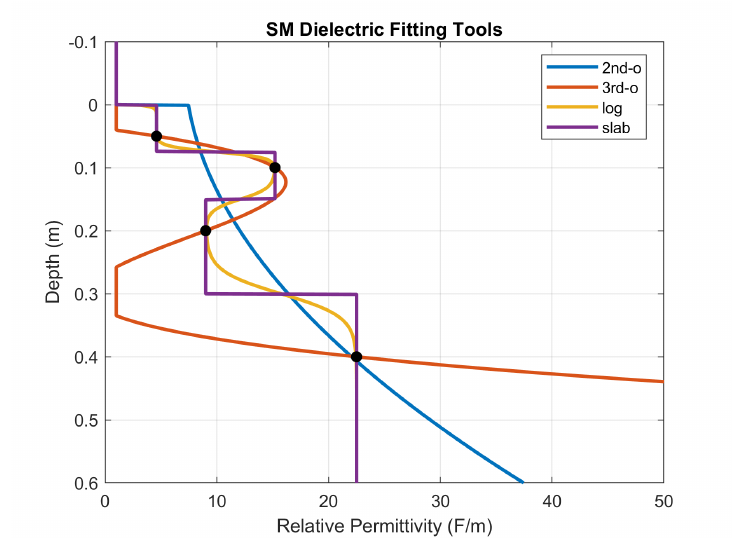
Figure 2. Discretized soil moisture profile representation in SCoBi model and simulator package. Each profile is fit using defined dielectric constant values (shown as black points) over a discretized profile. For clarity, only the relative permittivity is